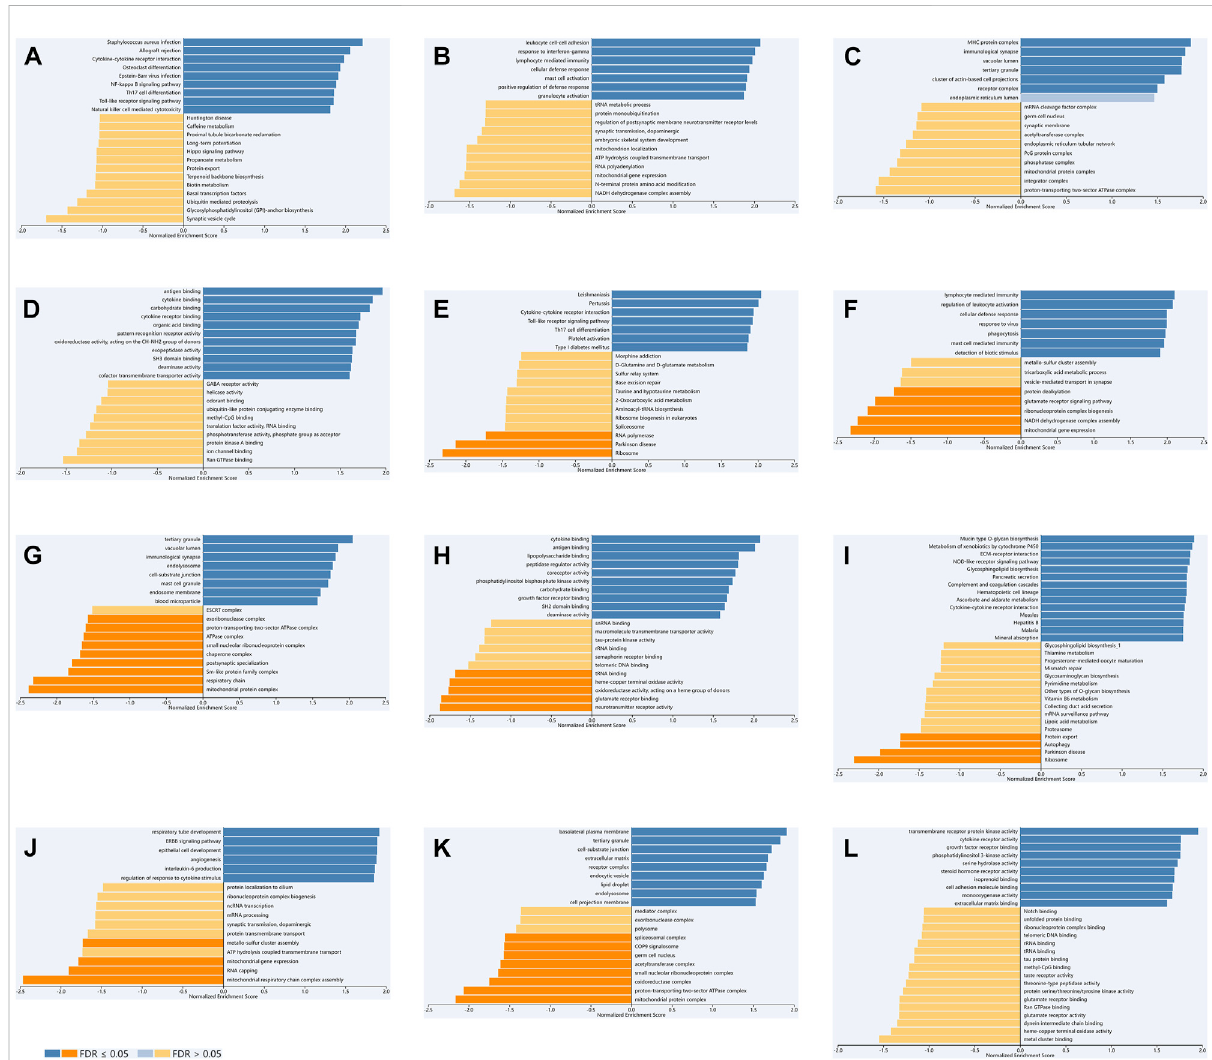
FIGURE 7 The GO and KEGG analysesof TLR3 in KIRC, LGG and PAAD based on LinkedOmics. KEGG (A) , BP (B) , CC (C) and MF (D) of TLR3 in KIRC. KEGG (E) , BP (F) , CC (G) and MF (H) of TLR3 in LGG. KEGG (I) , BP (J) , CC (K) and MF (L) of TLR3 in